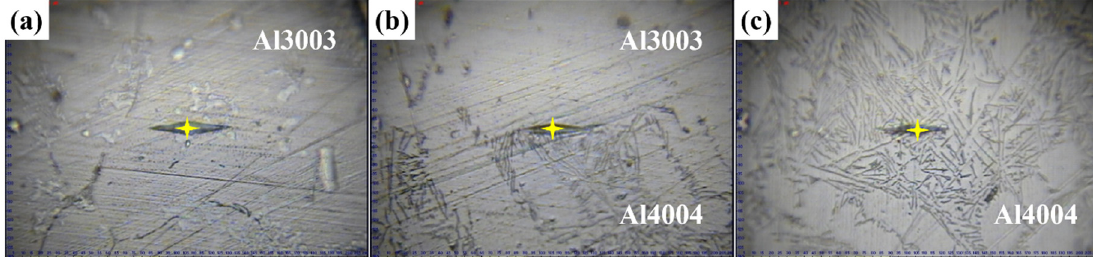
Figure 9. Examples of Knoop indenter traces on ( a ) Al3003 matrix, ( b ) Al3003/Al4004 interface, and ( c ) Al4004 matrix of round region during extrusion.